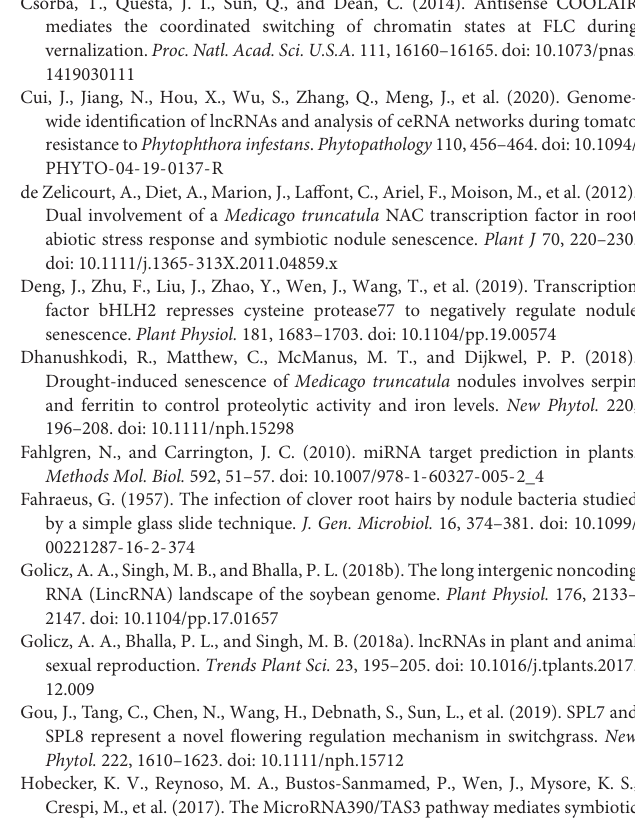
Supplementary Table 3 | The mapping results of all samples. Supplementary Table 4 | Target genes of DElncRNAs enriched in membrane component. Supplementary Table 5 | DElncRNAs targeted by